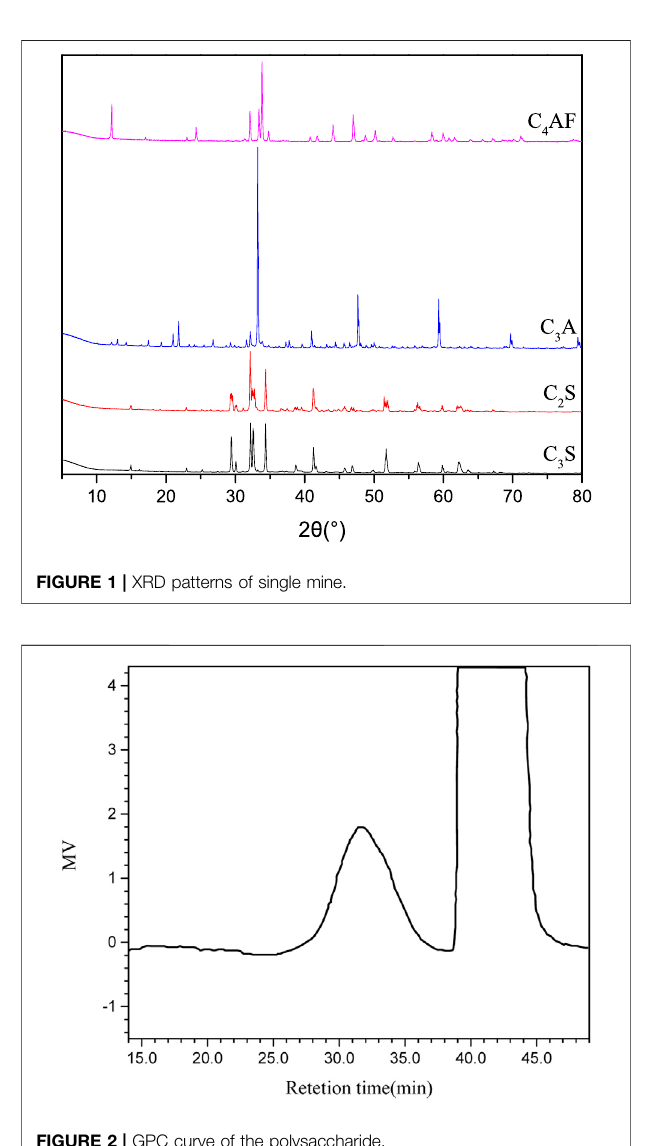
FIGURE 2 | GPC curve of the polysaccharide.